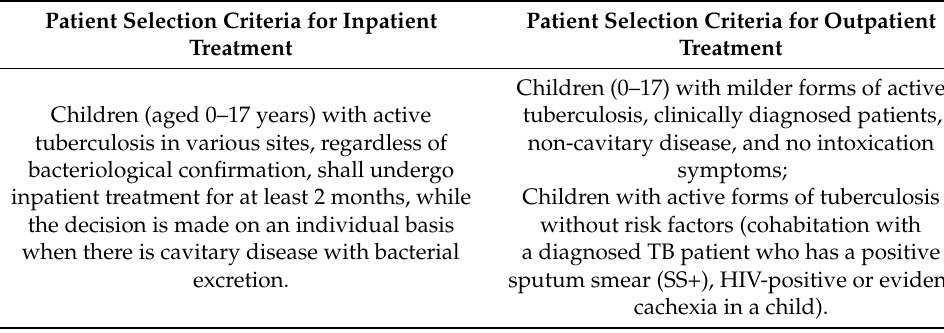
Table 1. Patient selection criteria for inpatient and outpatient treatment for children with tuberculosis in Uzbekistan, 2019.